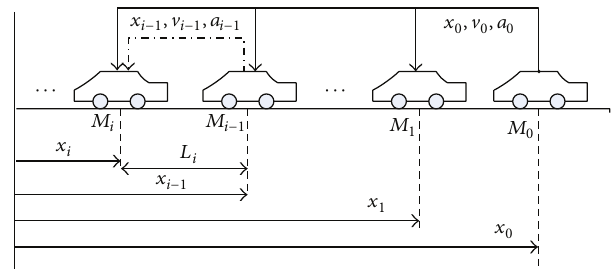
Figure 1: Spacing errors in a